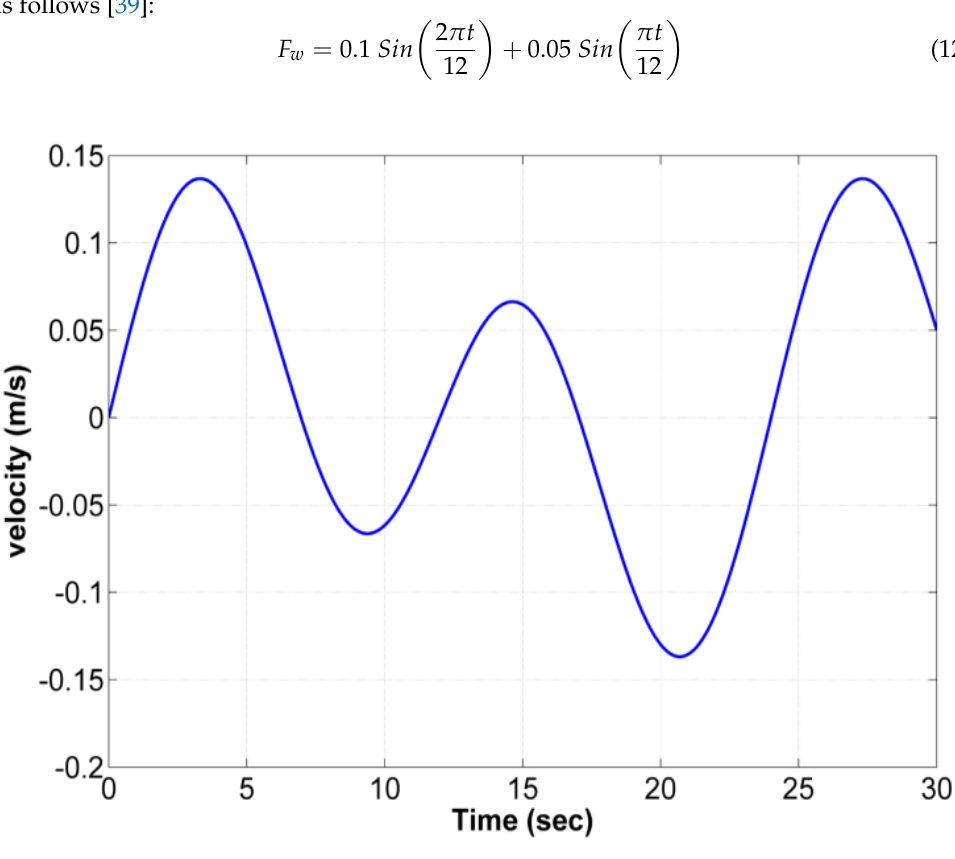
Figure 9. Irregular wave energy.